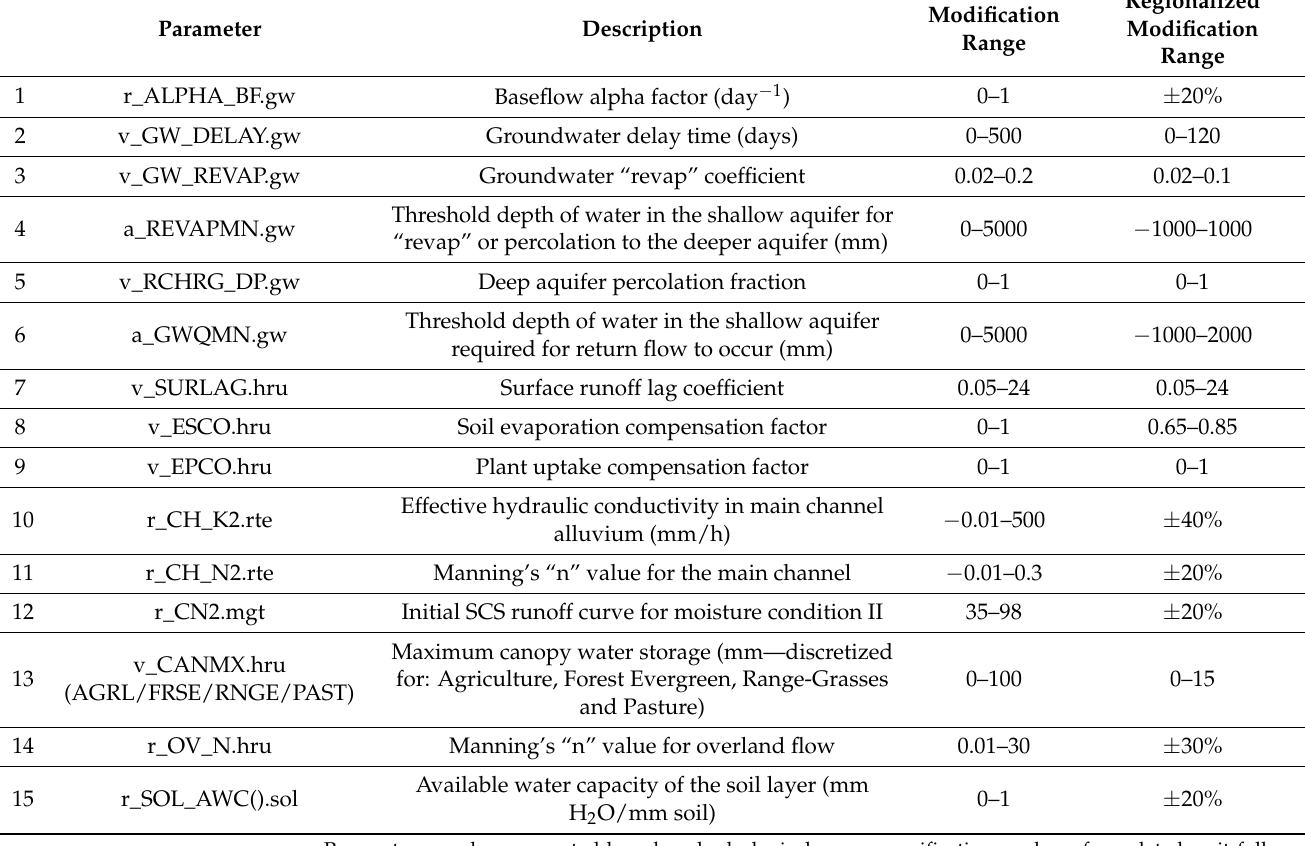
Table 2. General information about the calibration procedure; parameter name and type of change ap- plied to the parameter sampling, absolute modification range allowed by the model and regionalized modification range applied for the IRB based on areas that drain the UPRB from other